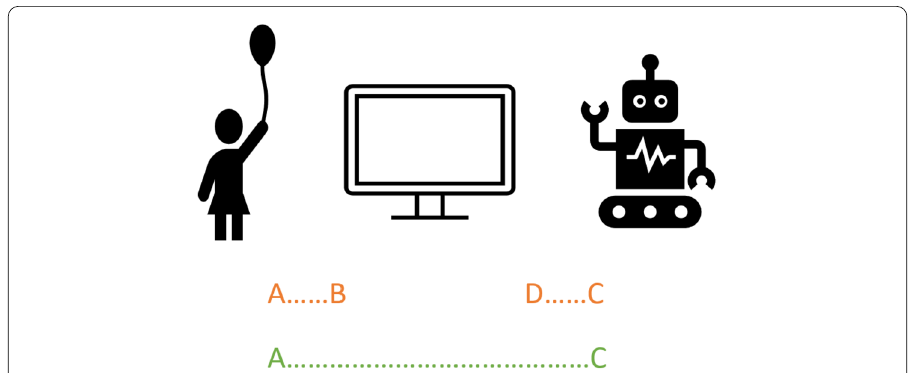
Figure 1 Matching pattern for which the triangle inequality does not hold but the relaxed triangle inequality